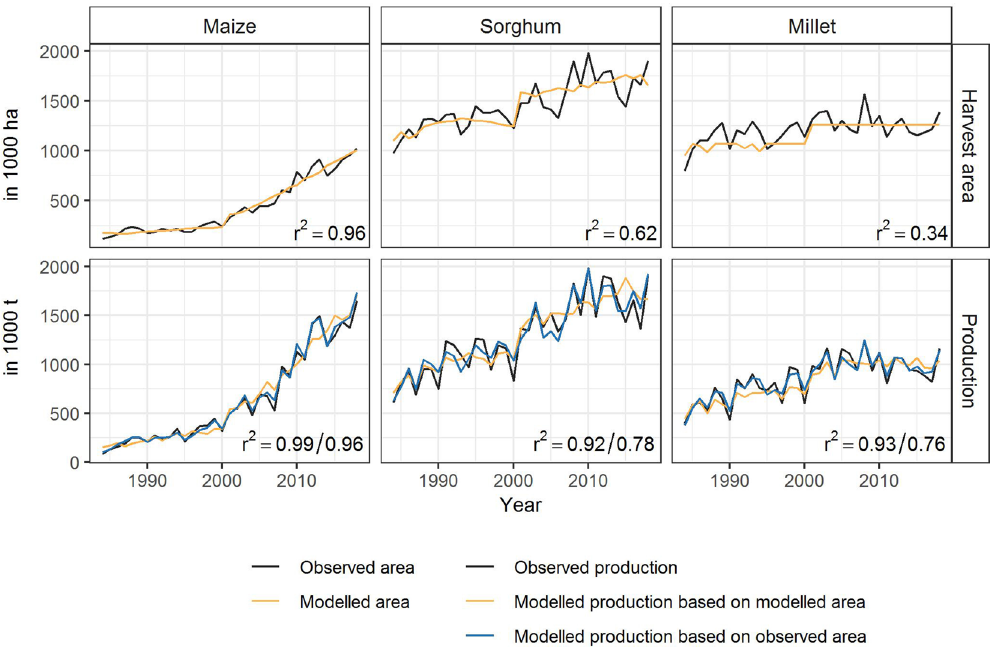
Figure 2. Harvest area and production for maize, sorghum and millet between 1984 and 2018. The black lines show the observed harvest area and production. For area, the best out-of-sample model was chosen. The modelled production is shown for two cases: (1) harvest area is known through e.g. farmer survey or satellite imageries (blue, first r 2 value); (2) harvest area is unknown and was modelled (yellow, second r 2